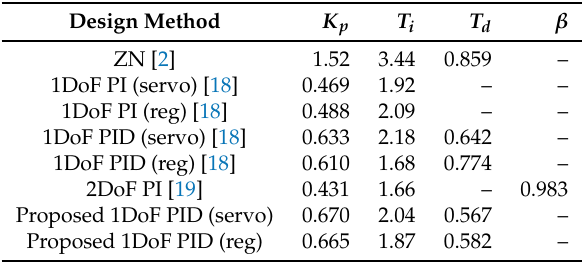
Table 9. Proportional-integral-derivative (PID) control system parameters.